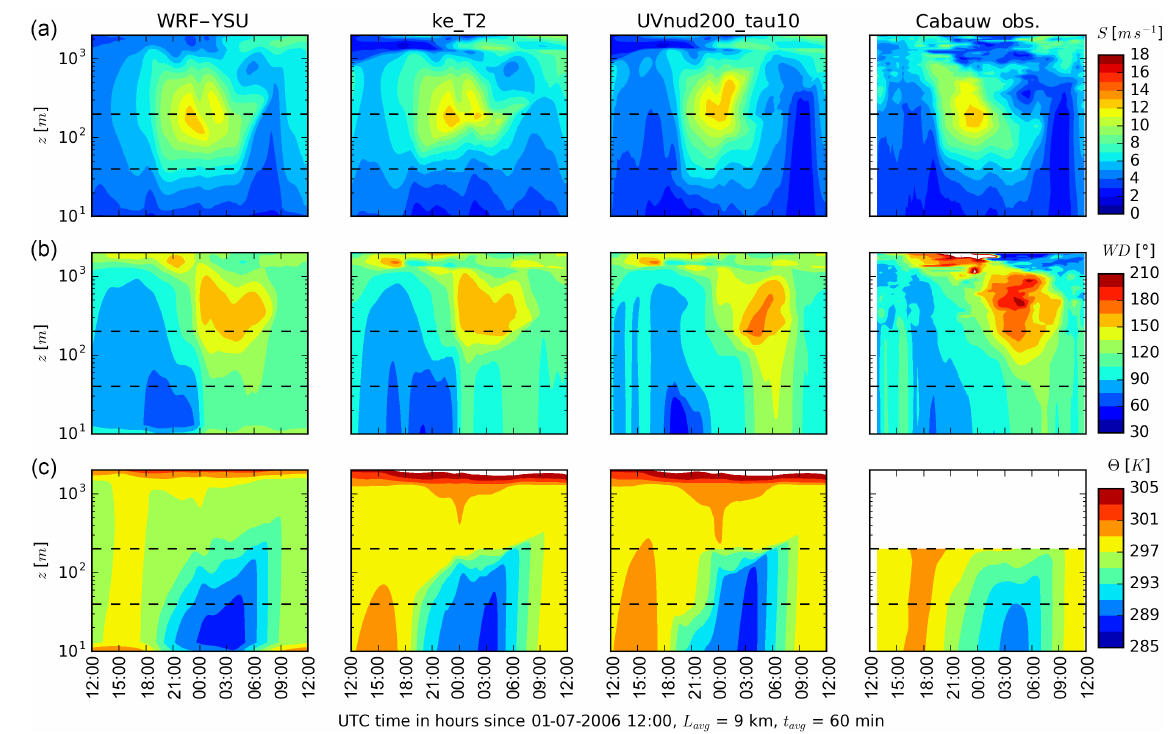
Figure 9. : Time–height contour plots of wind velocity S (top raw), wind direction WD (middle) and potential temperature (cid:50) (bottom) for the WRF simulation (first column), SCM simulation based on WRF mesoscale forcing and k - ε turbulence closure without (second) and with (third) velocity nudging between 40 and 200m, and observations (fourth). A reference rotor span (40–200m) is delimited by the dashed